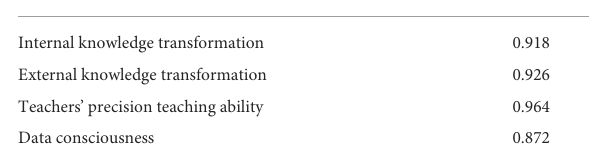
TABLE 2 Scales and Cronbach’s α